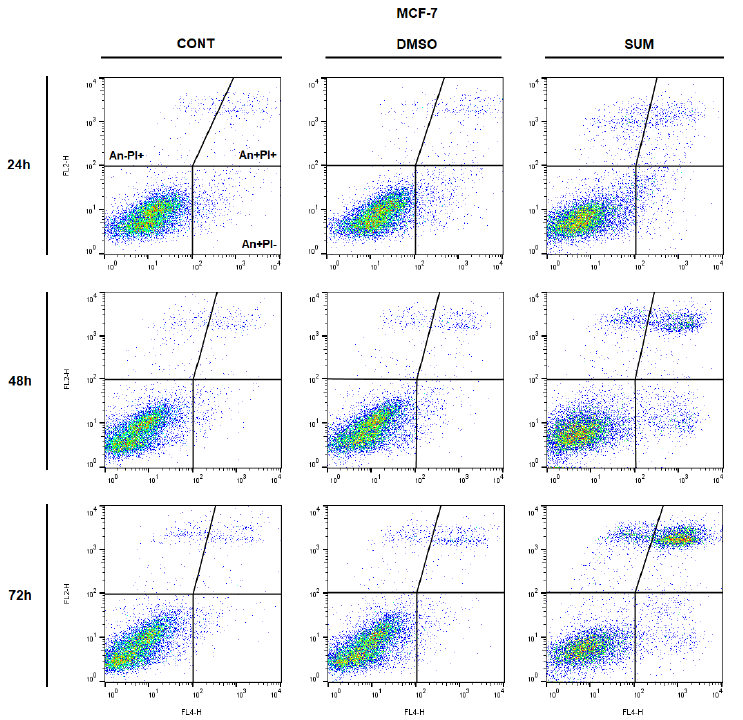
Figure 12. Representative diagrams of apoptotic cell diversification in MCF-7 cells after SUM treatment (155 µg/mL).